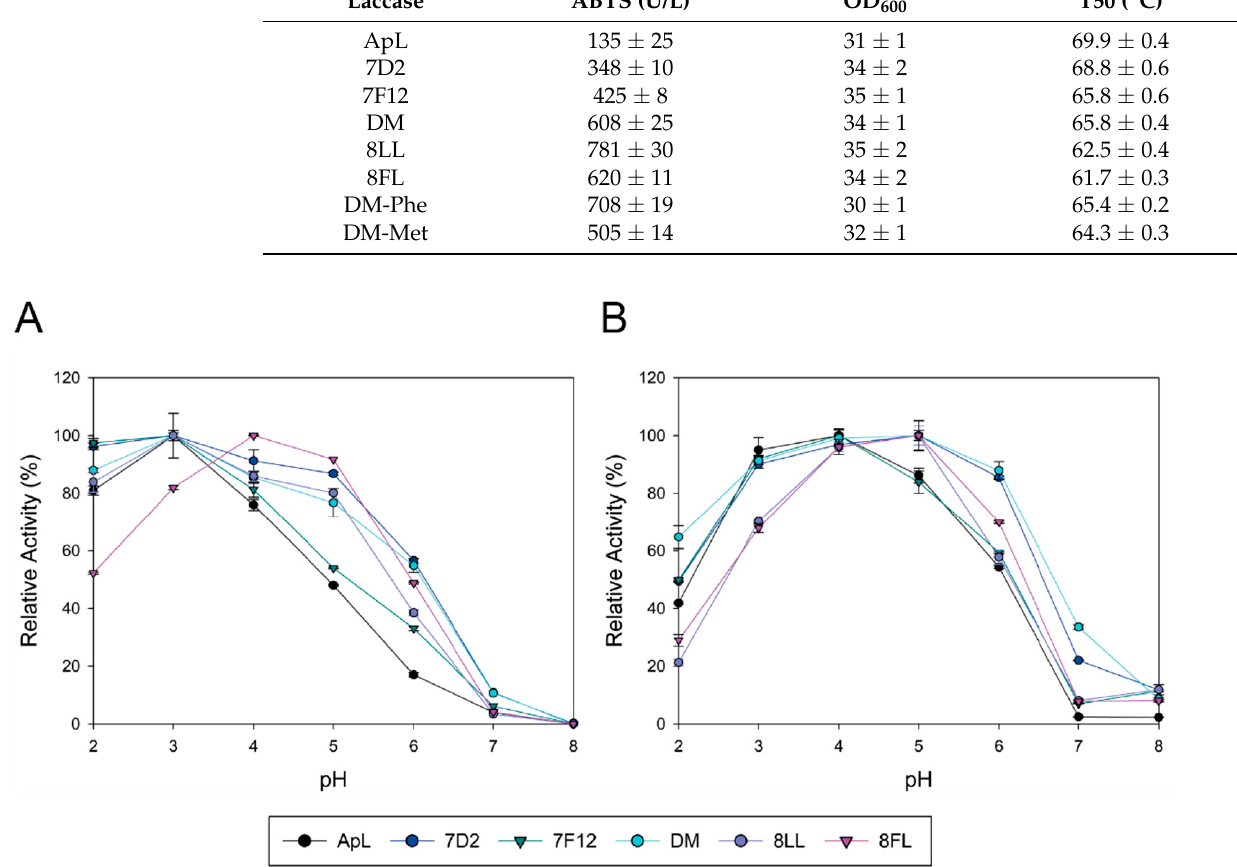
Figure 3. pH activity profiles of ApL and mutated variants for oxidation of ABTS ( A ) and DMP ( B ). Data are normalized to the maximum activity of each laccase.